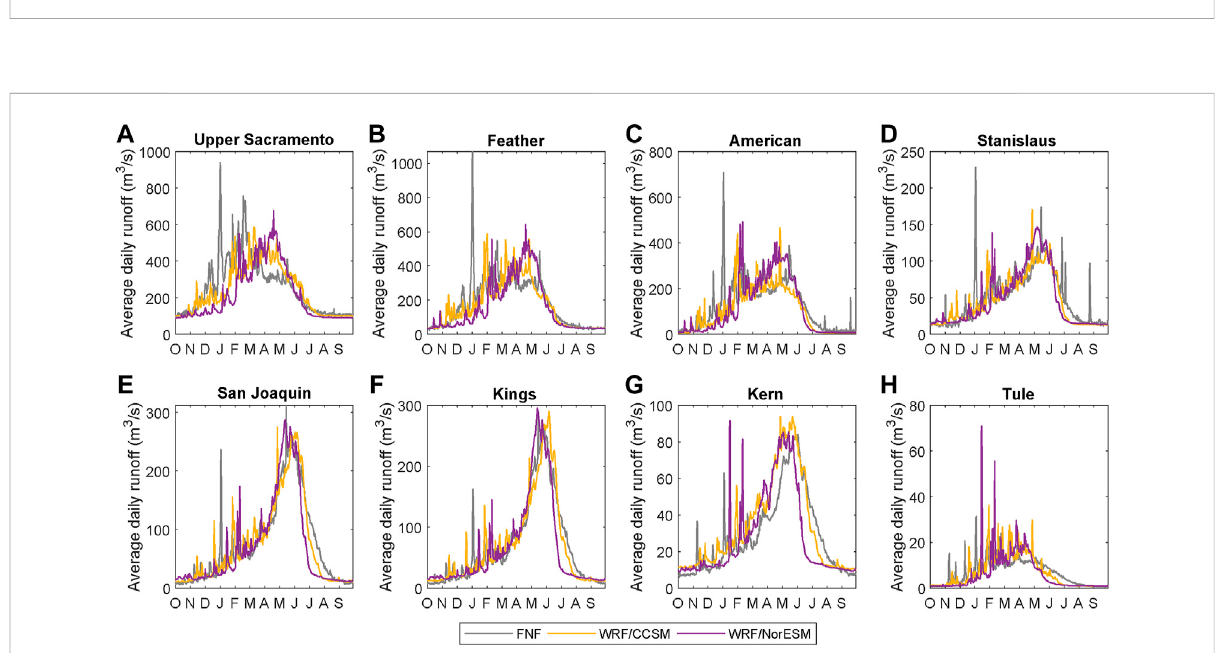
FIGURE 11 (A – H) Historical decade-averaged daily runoff from eight Sierra Nevada basins with available estimates for full natural fl ow